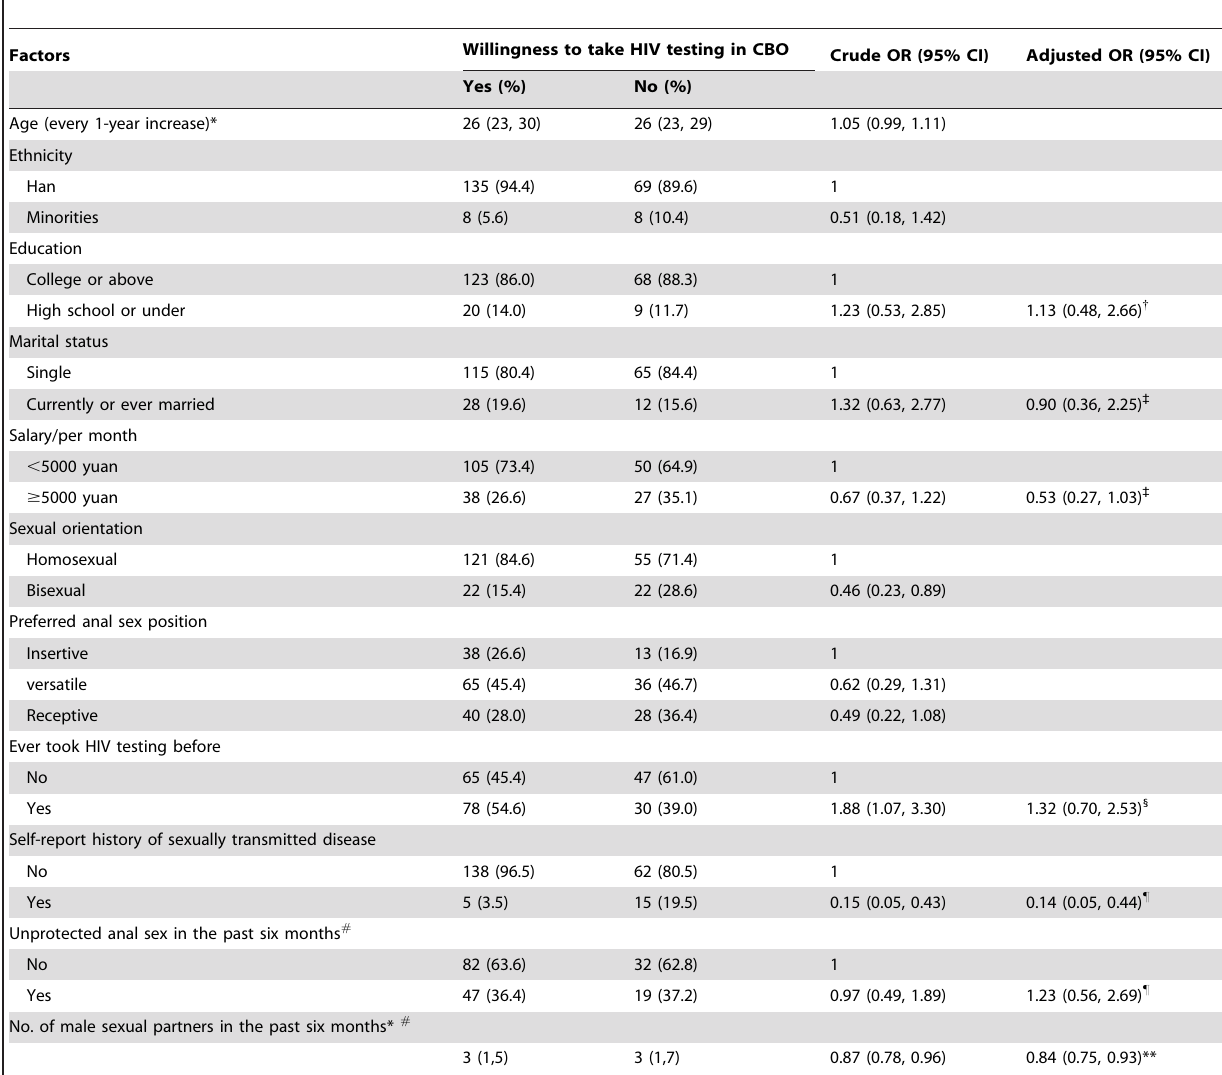
Table 2. Factors associated with willingness to go to community-based organization (CBO) for taking HIV testing among Chinese men who have sex with